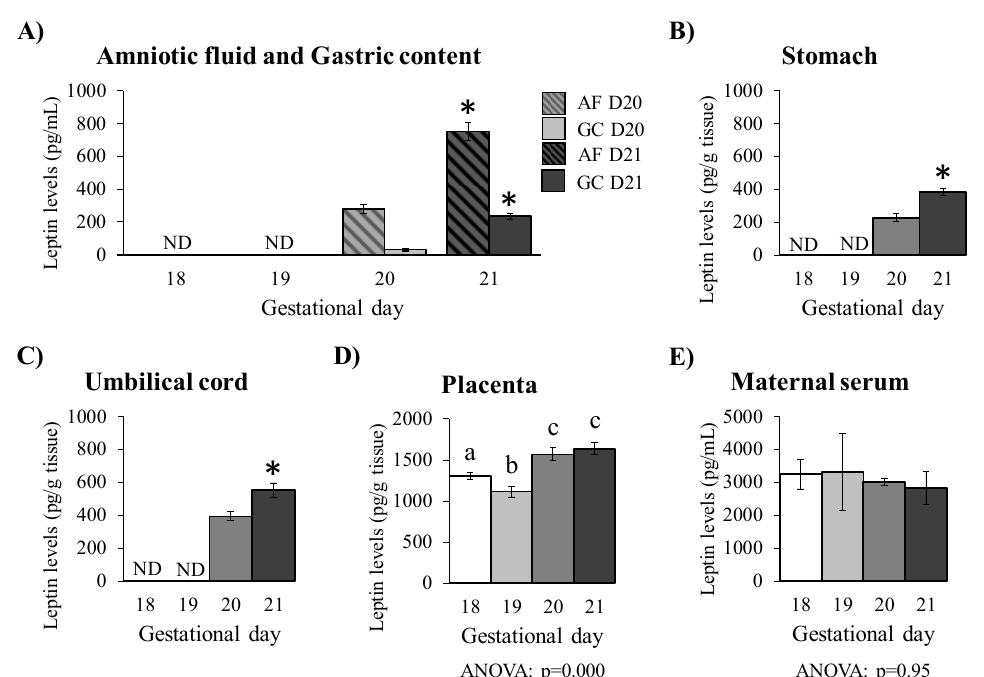
Figure 1. Leptin levels in rat amniotic fluid (AF) and gastric content (GC) ( A ), stomach ( B ), umbilical cord ( C ), placenta ( D ), and maternal serum ( E ) at days 18, 19, 20, and 21 of gestation. Leptin levels in AF and GC have been represented together for a clearer comparison. Pools of stomach, umbilical cord, and GC samples ( n = 2–5 foetuses per pool) were required for leptin measurement. Data are mean ± S.E.M. ( n = 22–27 foetuses per gestational day; n = 2 dams per gestational day). Statistics: Student’s t -